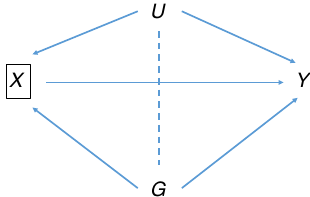
Fig. 1 Directed acyclic graph of association of SNP G with prognosis Y conditional on incidence X . U is a composite variable including all common causes of X and Y , and may include polygenic effects as well as non-genetic risk factors. In our examples, X is idiopathic pulmonary fi brosis or Crohn ’ s disease, and Y is survival or prognosis. Conditioning on X induces the moralised association between G with U shown by the dotted line. This creates association between G and Y via the path G (cid:2) U ! Y in addition to the direct effect G ! Y